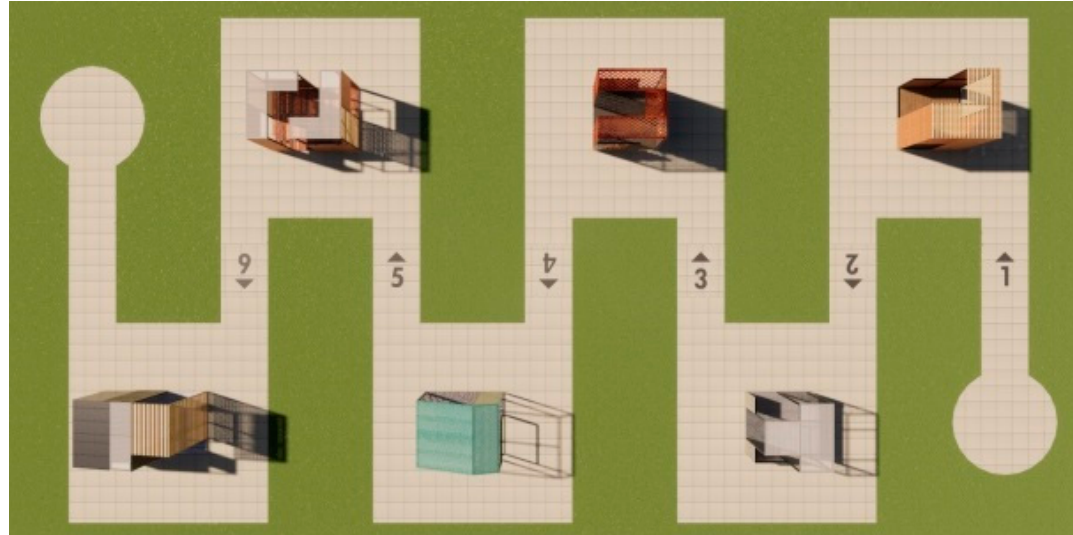
Figure 10. Immersion in architectural spaces.